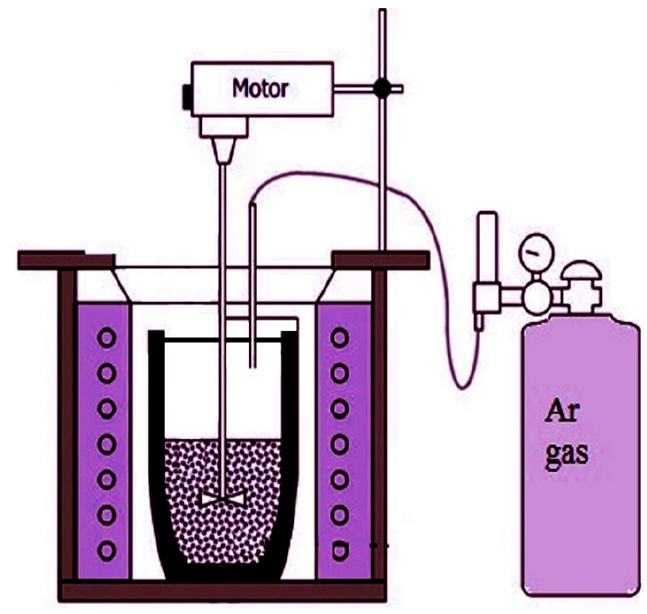
Figure 1. The stir casting process of Al/TiC composites.